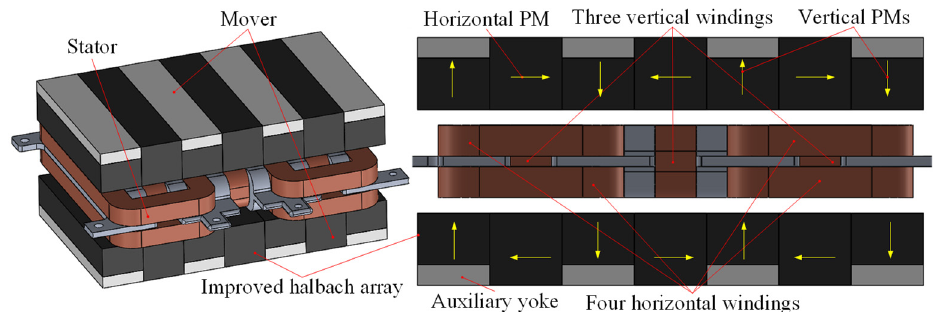
Figure 1. Configuration of the 2-DOF electromagnetic actuator.